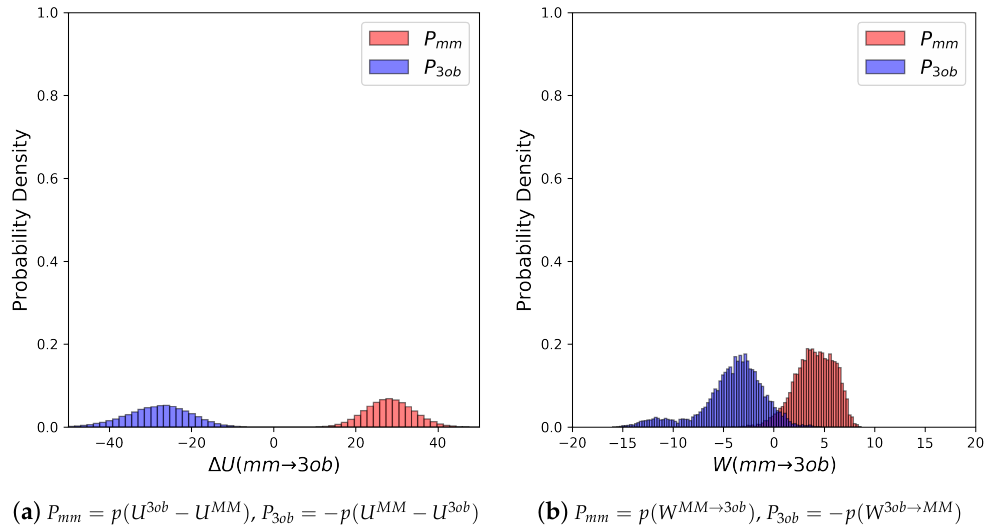
Figure 6. ( a ) Molecule 5 ’s potential energy “forward” ( P mm ) and “backward” ( P 3 ob ) distributions plotted as “offset” from the ∆ U MM → 3 ob to simplify the x-axis. ( b ) Molecule 5 ’s nonequilibrium work “forward” ( P mm ) and “backward” ( P 3 ob ) distributions plotted as “offset” from the W MM → 3 ob to simplify the